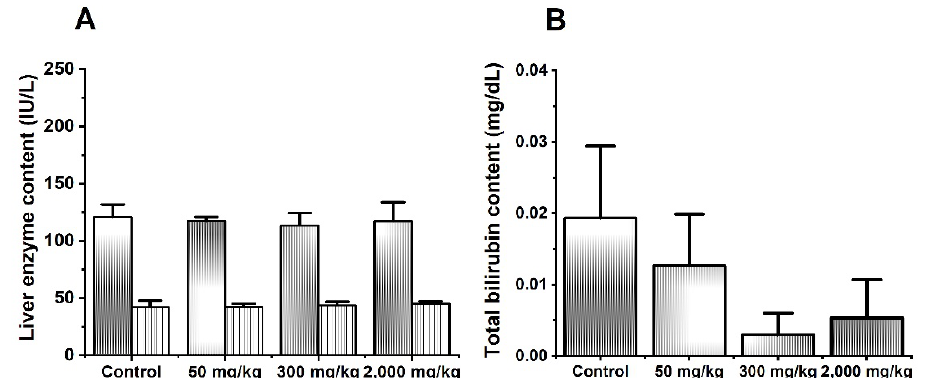
Figure 1. Effects of MIX–160 on liver enzyme content ( A ) and bilirubin ( B ) in acute oral toxicity evaluations. ALT is represented in white with gray lines. AST is represented in solid gray.